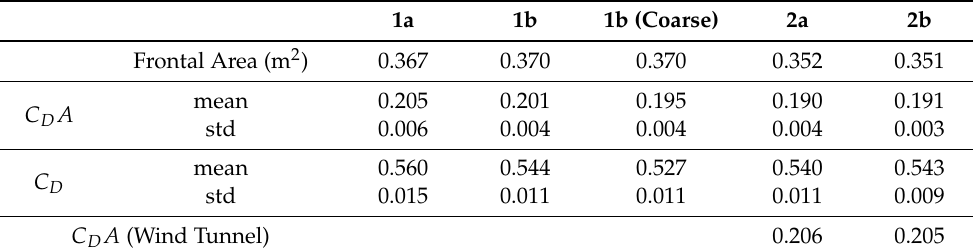
Table 3. The comparison of drag